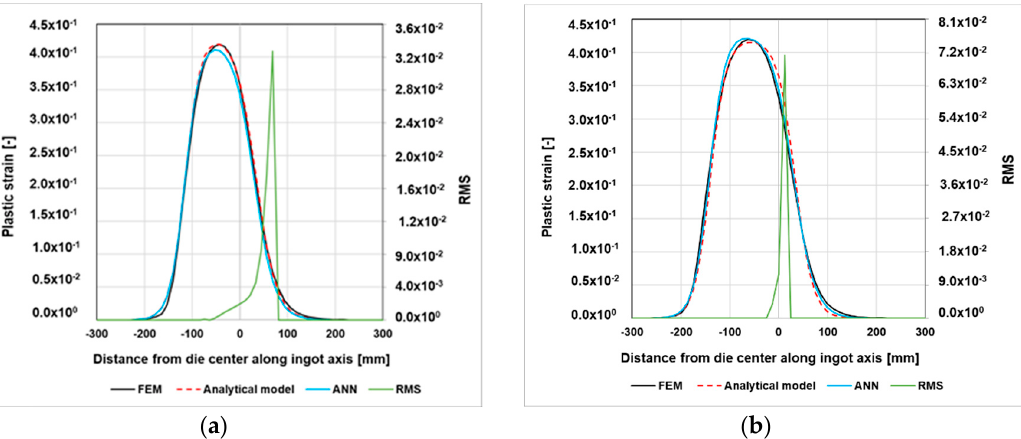
Figure 14. Total equivalent plastic strain as a function of length for Sb 0 = 300 mm, reduction of 25% at 1200 °C for second ( a ) and third stroke ( b ).